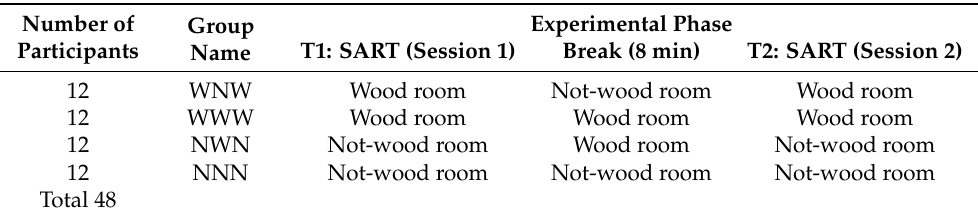
Table 1. Attention test experimental design (SART: sustained attention to response task; W: wood room; N: not-wood